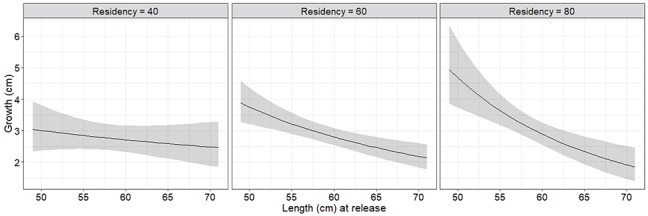
Predicted growth (length, cm) of Atlantic salmon kelts that returned to Campbellton River as consecutive spawners in the summer of 2016 plotted as a function of fork length at release and marine residency (days). Shaded area represents the 95% prediction confidence intervals.